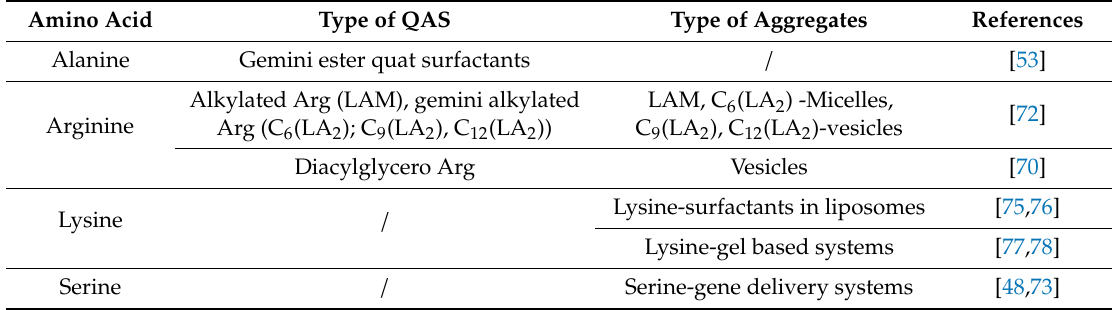
Table 1. Examples of amino-acid residue containing quaternary ammonium compounds (QACs). Amino